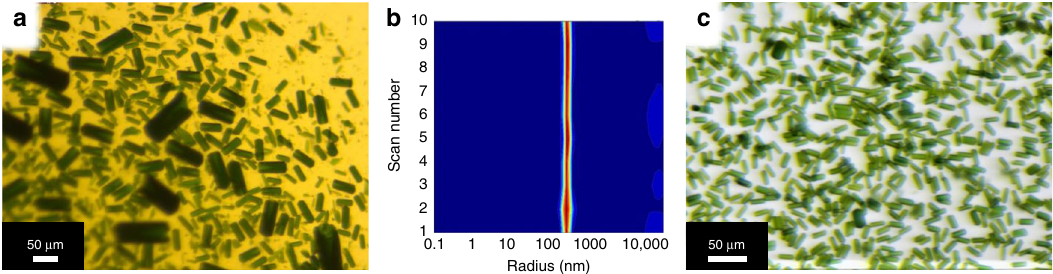
Fig. 1 Crystals of PSI. a Variable-size PSI crystal distribution, grown by ultra fi ltration. b DLS (ten 18-s scans, numbered consecutively from 1 to 10, “ Scan Number ” ) of nanocrystals with uniform size distribution used for seeding. c PSI crystals of uniform size of 5 × 5 × 15 µ m grown by using the RAMS method